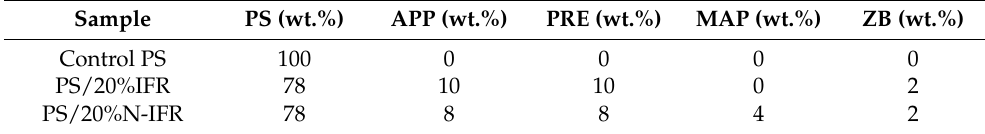
Table 1. Formulations of PS